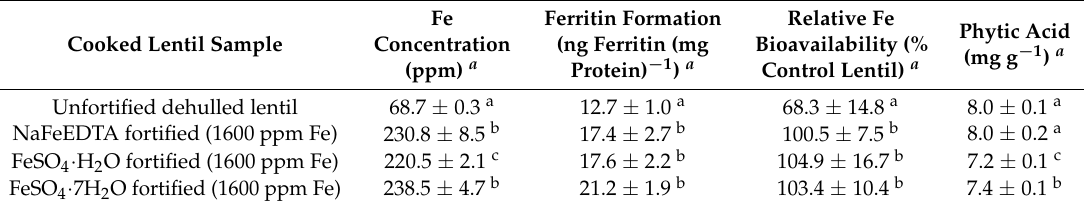
Table 3. Mean iron (Fe) concentration (ppm), relative bioavailability (ng ferritin (mg protein) − 1 ) and phytic acid concentration (mg g − 1 ) of four cooked freeze-dried lentil samples.